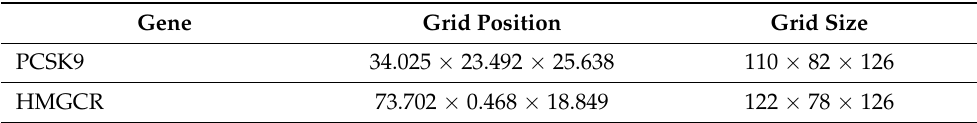
Table 3. The grid position and grid size of the targeted